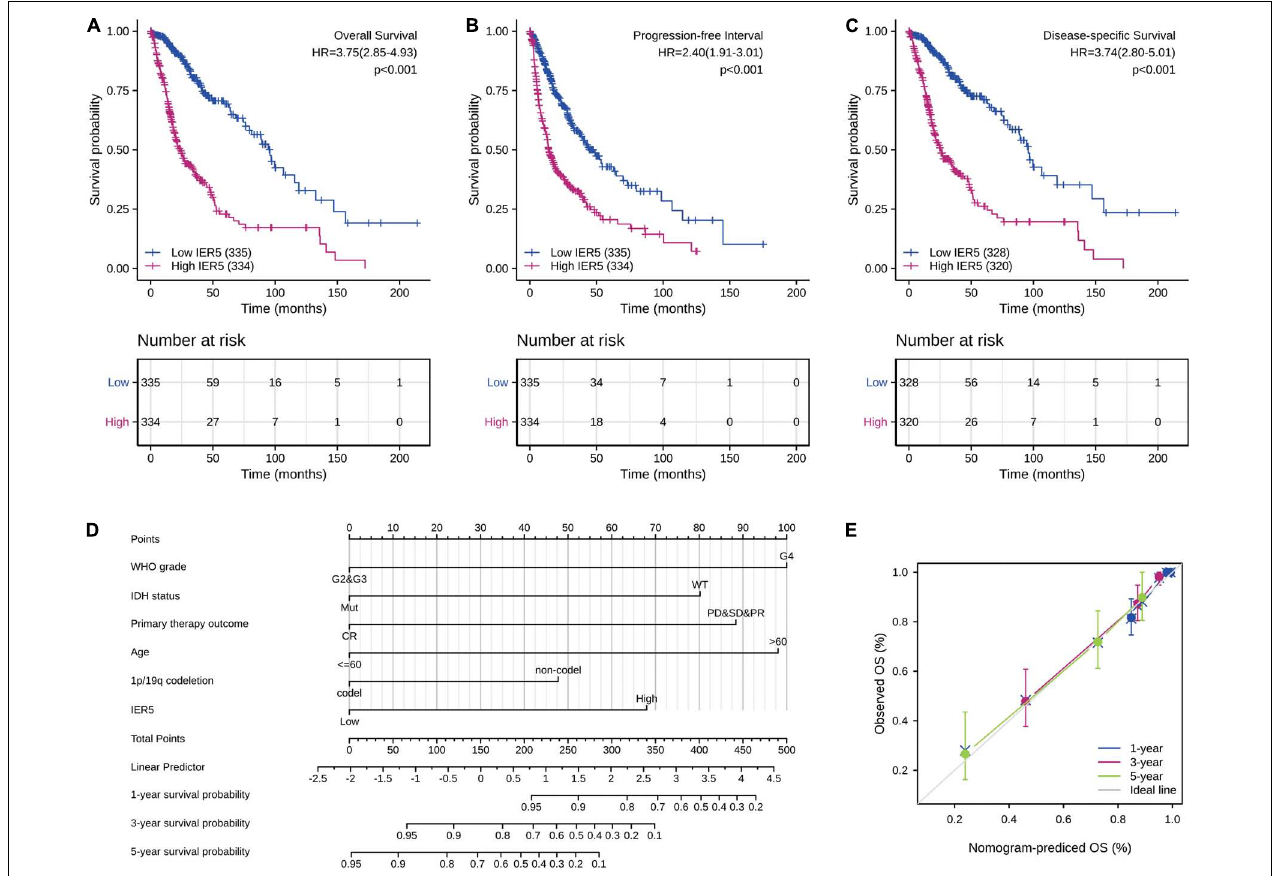
FIGURE 4 | Impact of IER5 expression on overall survival, progression-free interval, and disease-specific survival in glioma patients in the TCGA cohort (A–C) . Construction and performance validation of the IER5 -based nomogram for glioma patients (D,E) .